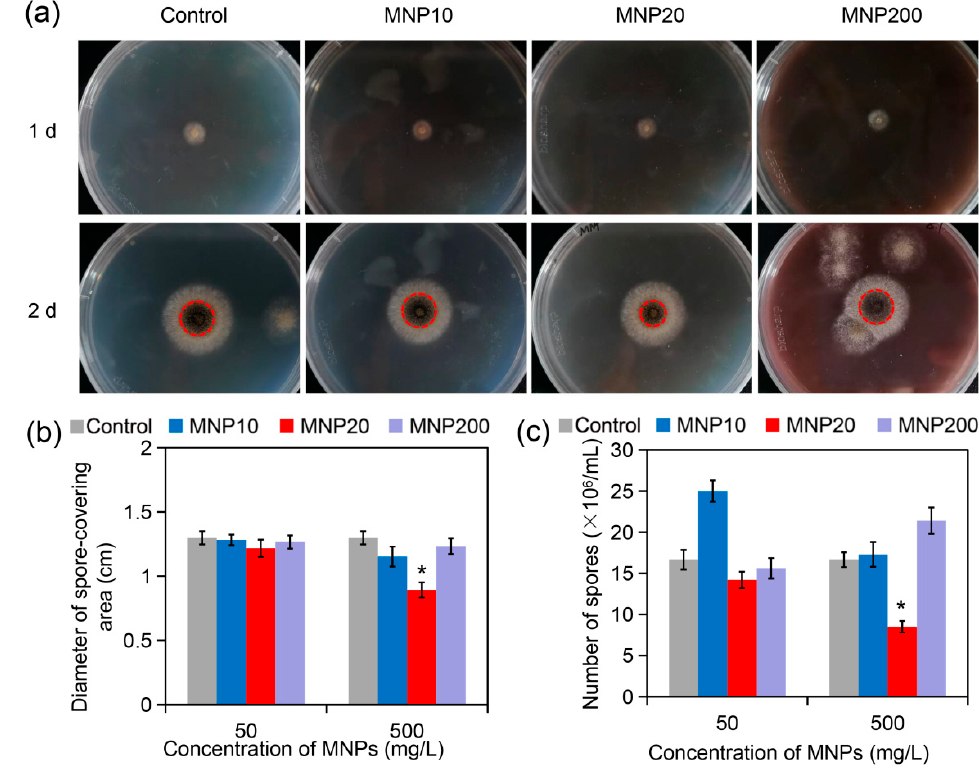
Figure 2. Impact of the MNPs with different sizes on growth and sporulation of A. niger . ( a ) Images of the A. niger -culturing PDA plates containing the MNPs at 500 mg/L. The plates were cultured at 30 °C for 1 d (24 h) or 2 d (48 h), followed by photographing. The red cycles indicated the areas of spore covering. ( b ) Diameters of spore-covering areas in different groups after two days of culturing. ( c ) Number of spores in different groups. The spores in each plate after six days of culturing were washed by 10 mL of distilled water, and the spores were counted by using hemocytometers. The asterisks (*) indicate significant difference between the MNP20 group and other groups ( p < 0.05).